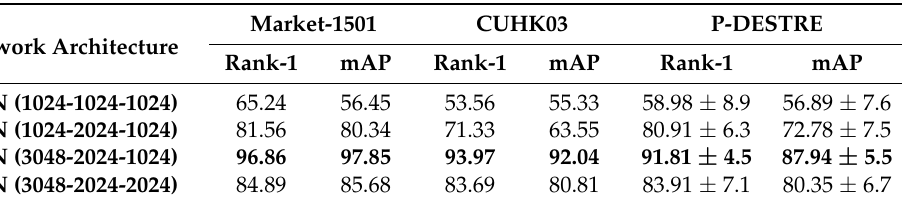
Table 6. Results acquired for different DBN models using the image size of 64 × 64 pixels from three different ReID datasets.